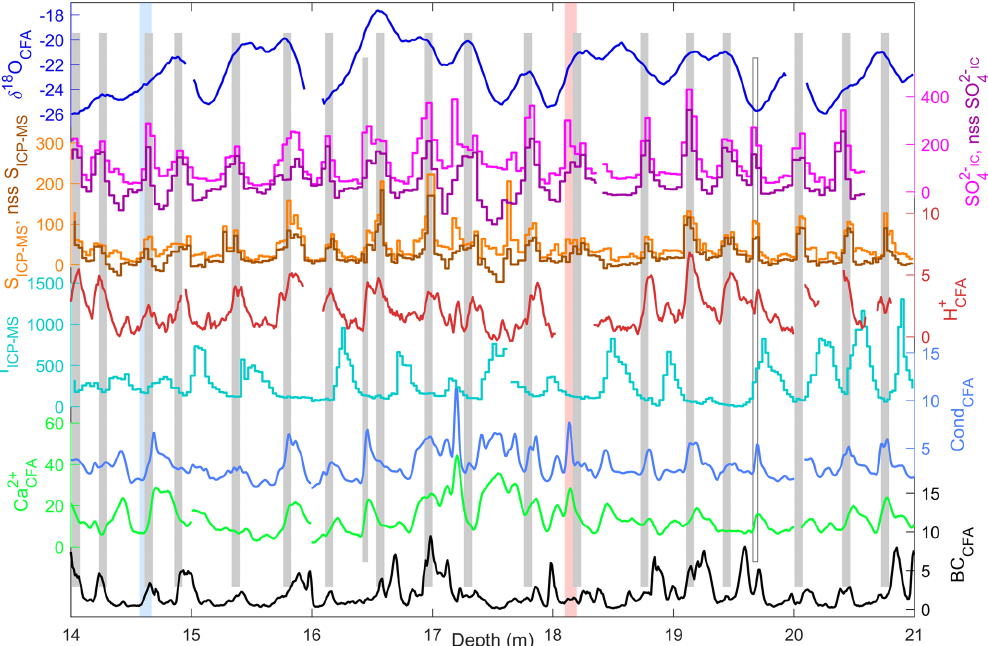
Figure 4. Manual assignment of annual layers in an upper section of the RICE core. All units are in ppb, except for δ 18 O (in ‰), H + (in µeqL − 1 ), and conductivity (in µScm − 1 ). The CFA chemistry records are smoothed with a 3cm moving-average filter. The timescale is constrained by two tie points within this interval: the isotope match to RID-75 (blue bar; 14.6m) and the Raoul tephra horizon (red bar; 18.1m). At two locations, the annual layering is unclear (shorter bars) but can be mostly resolved based on the tie-point ages. As a result, the uncertain layer at 16.6m (short grey bar) is included as a year in the timescale, whereas the uncertain layer at 19.7m (short white bar) is not. For the second layer, the sulfate record suggests that it is an annual layer, but this is not supported by iodine and δ 18 O. As we assume an uncertainty of ± 1 year for the tie-point ages, the layer at 16.6m could possibly be removed from the timescale while still adhering to the age constraints. The existence of this uncertain layer therefore gives rise to a 1-year increase in the timescale uncertainty.